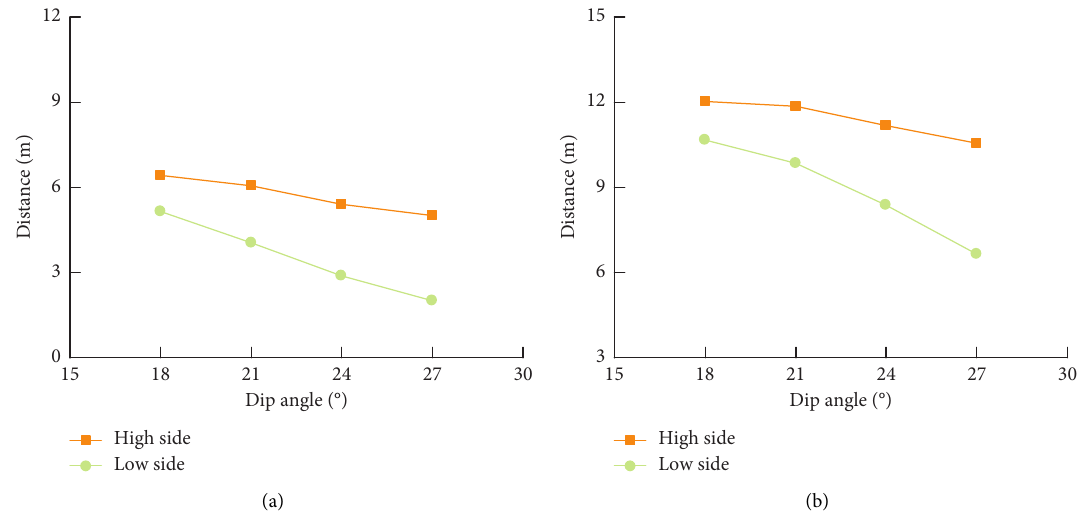
Figure 7: Curve of the change in stress concentration peak with the side distance of the two sides of the roadway with inclination angle. (a) 10MPa. (b)